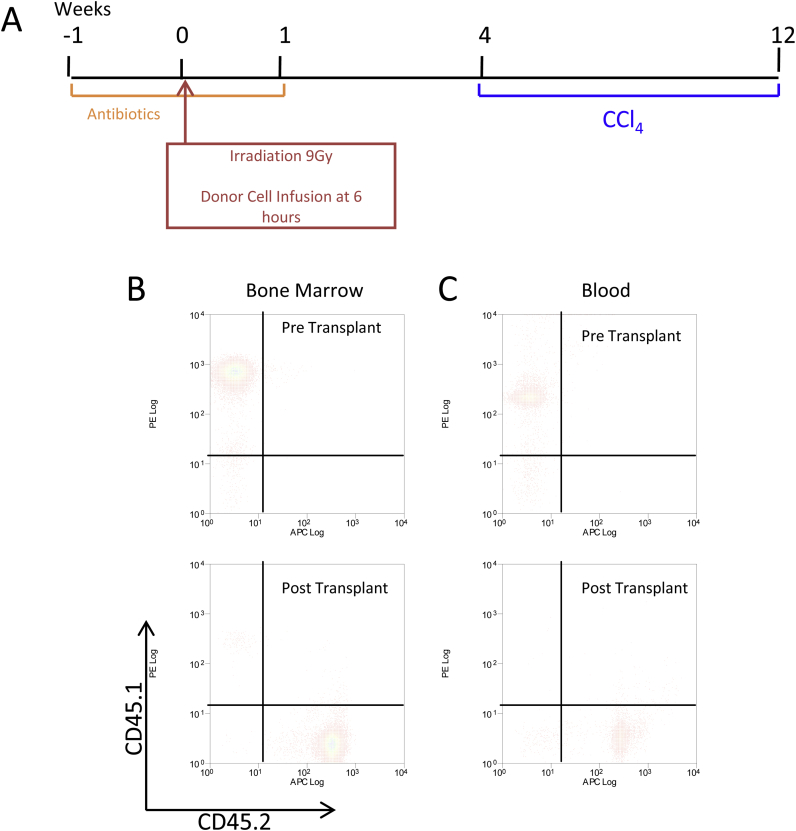
Bone marrow transplantation studies. (A) Recipient BoyJ (CD45.1) mice received Baytril (Bayer Corporation, Dallas, TX) antibiotic in drinking water 1 week before and 1 week after irradiation with 9 Gy in 2 divided doses on the same day. Bone marrow cells were obtained from donor C57BL6 (CD45.2) mice by flushing of the tibia and femurs. Six hours after irradiation donor bone marrow cells were infused into recipient mice by tail vein injection. After a 4-week recovery, transplanted mice were divided into 2 groups at random with 1 group receiving twice-weekly intraperitoneal administration of carbon tetrachloride (1 mg/kg) in mineral oil and the other group receiving intraperitoneal injections of mineral oil alone for a further 8 weeks. (B and C) Samples of bone marrow and peripheral blood were treated with red cell lysis buffer and labeled with fluorescent antibodies to CD45.1 and CD45.2. Analysis of CD45 expression by flow cytometry showed almost complete CD45.2 expression after transplantation compared with CD45.1 expression before transplantation. Representative flow cytometry plots of multiple experiments are shown.